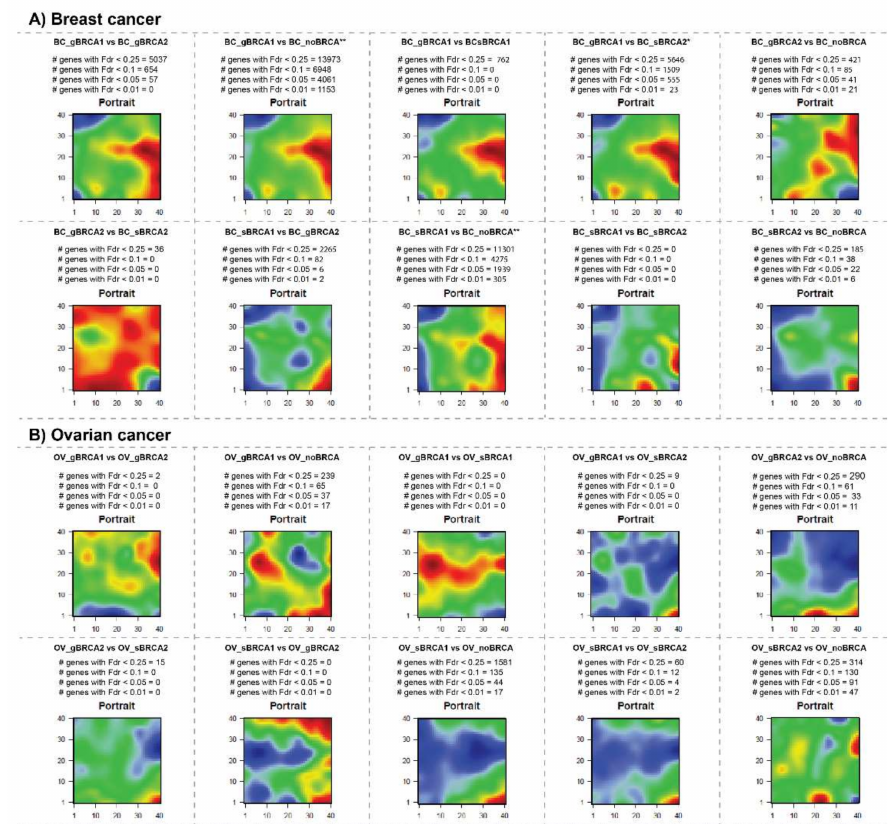
Figure 2. Pairwise differential expression portraits in the breast ( A ) and ovarian ( B ) cancers. The red- to-blue color gradient on maps is scaled to indicate up- to down-regulation of gene expression values on a given map, respectively. The number of significantly deregulated genes at different FDR thresholds are given above each map. The largest numbers of de-regulated genes ( n > 100 and n > 1000 at Fdr < 0.05) are indicated by * and **, respectively. See also Table